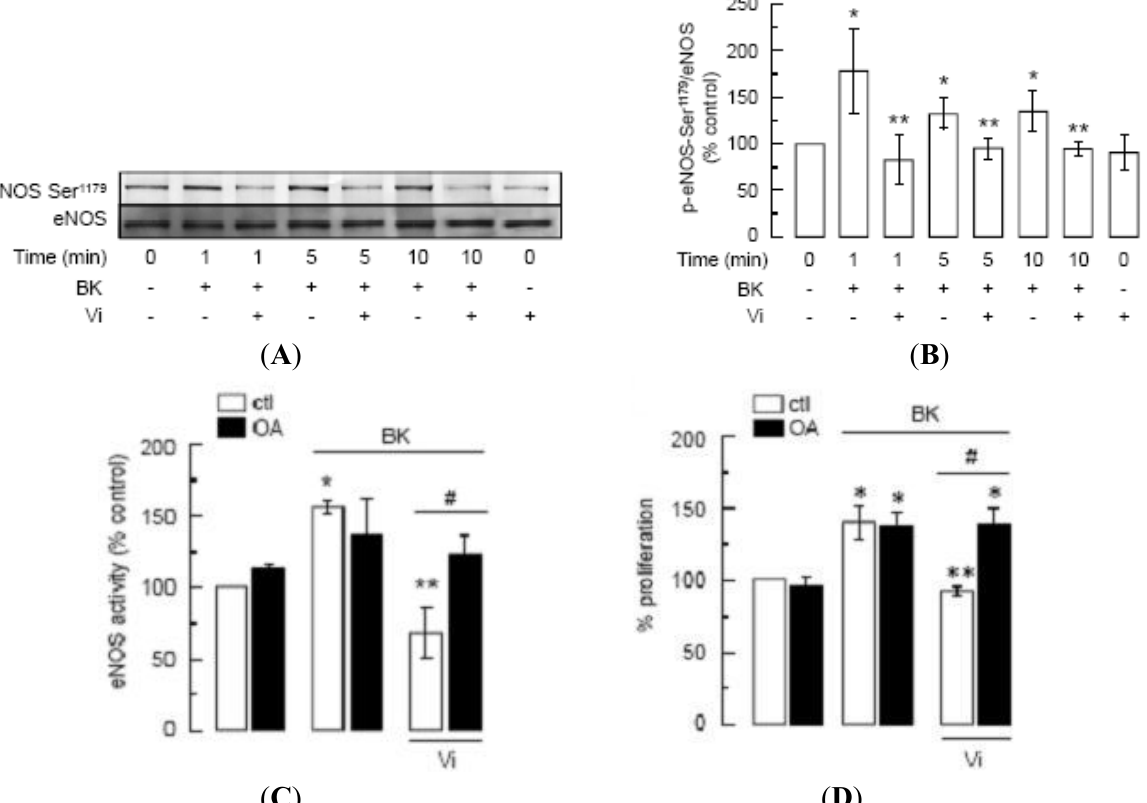
Figure 7. Vasoinhibins prevent the BK-induced phosphorylation of eNOS at Ser 1179 by activating